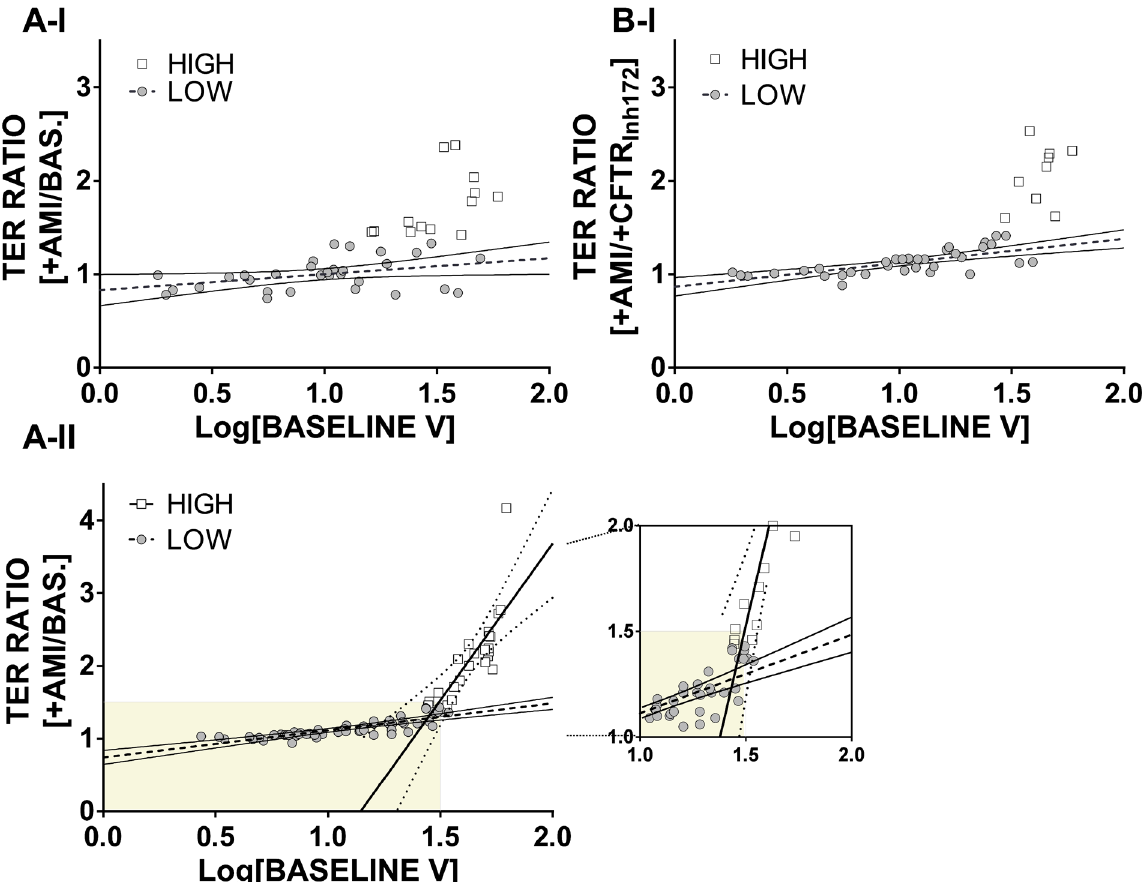
Fig 8. Relationship between baseline voltage and response of TER after amiloride addition. Logarithm of baseline V plotted against ratio of TER upon amiloride addition in drug regime I, applying the initial baseline (A-I), or the rolling baseline approach (B-I). In drug regime II (A-II), grouping produced a significant difference between the two groups (LOW, n = 57; HIGH, n = 24). For both drug regimes, grouping was performed as in Figs 5 and 6. Additional regression and statistical analysis data are shown in Table D, S1